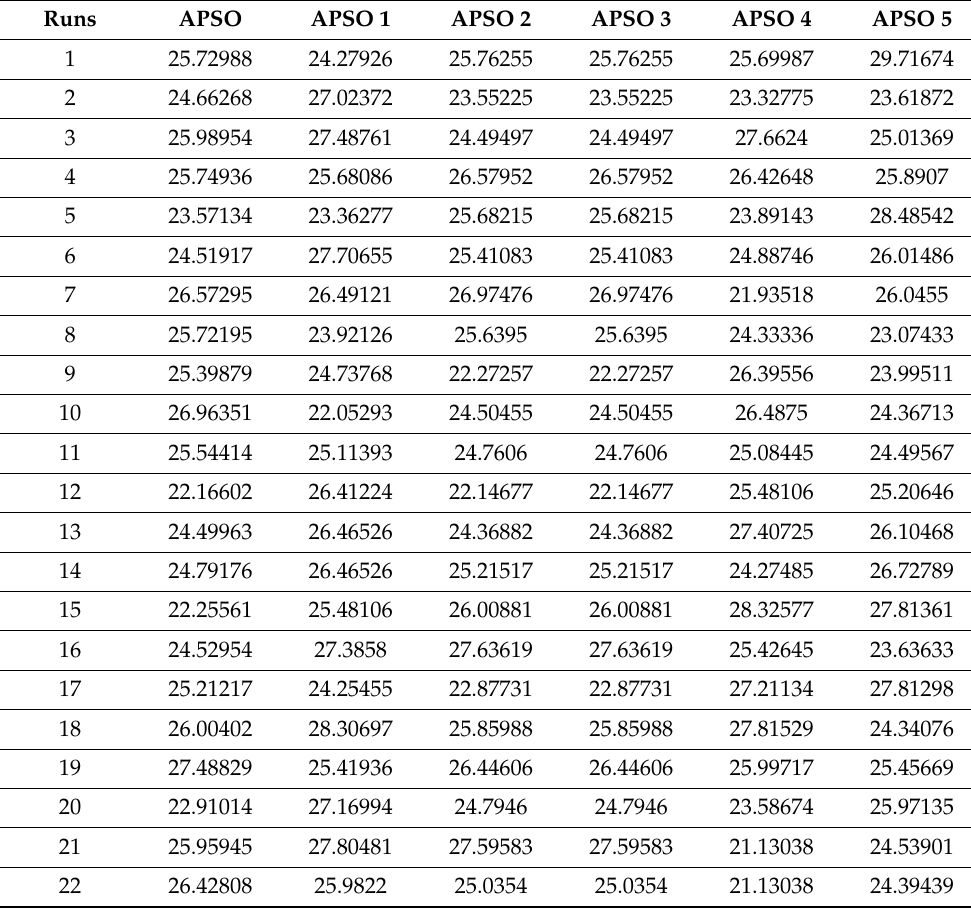
Table 9. APSO and its variants’ results for 100 PHEVs (30